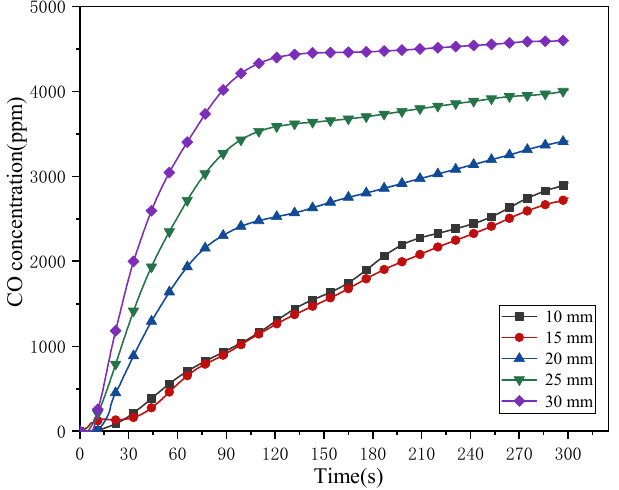
Figure 15. The CO concentration in transition room with 6 mm hole diameters.